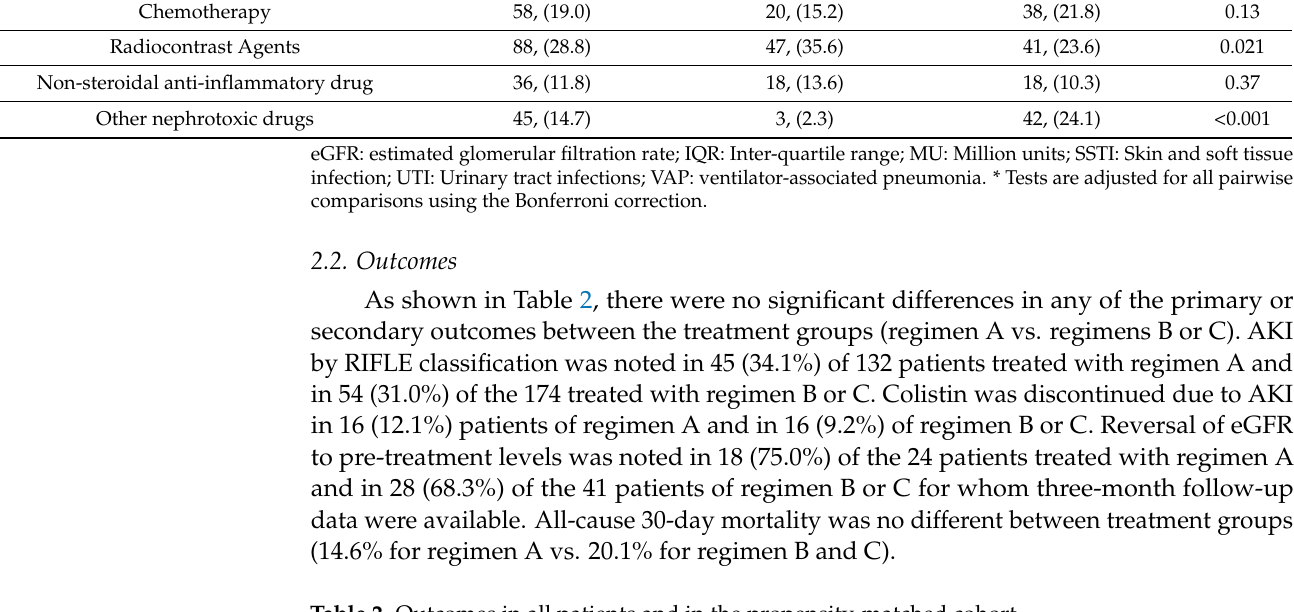
Table 2. Outcomes in all patients and in the propensity-matched